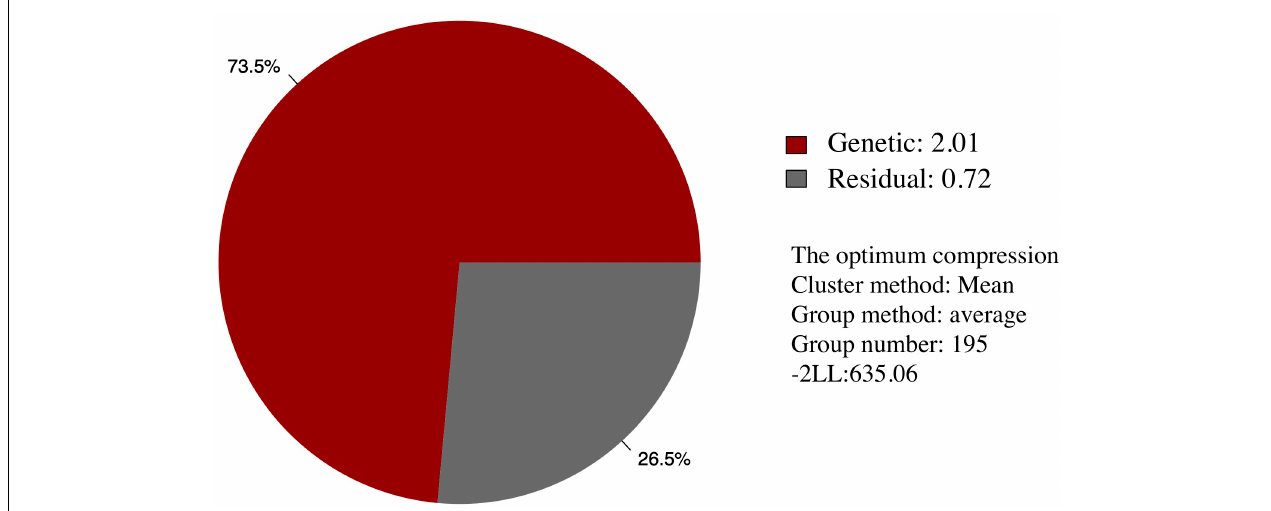
FIGURE 2 | Narrow-sense heritability of the resistance of peach gummosis disease calculated by whole genome SNP markers. “Genetic” and “Residual” means estimated genetic and residual variance in the mixed linear model. The optimum compression information indicates the optimal algorithm to calculate the group kinship matrix, the optimal clustering algorithm, the optimal number of groups in the compress mixed linear model. “-2 LL” is the abbreviation of -2 multiply likelihood value, which means the level of model fitting.